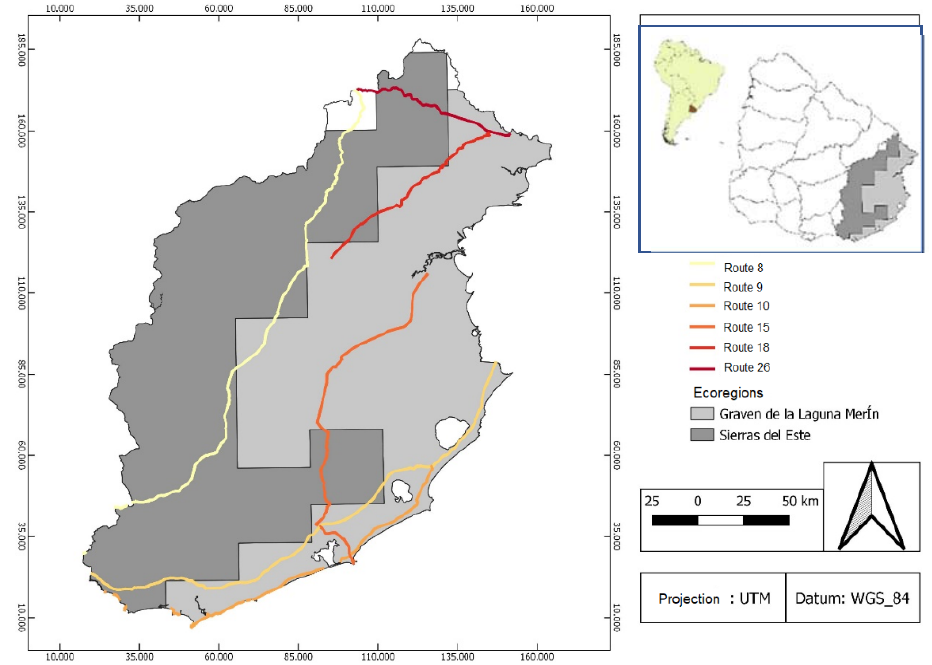
Figure 1. Study area in Uruguay, which includes the Sierras del Este (dark grey) and Graben de la Laguna Merín (light grey) ecoregions. We marked the roads used for modelling.